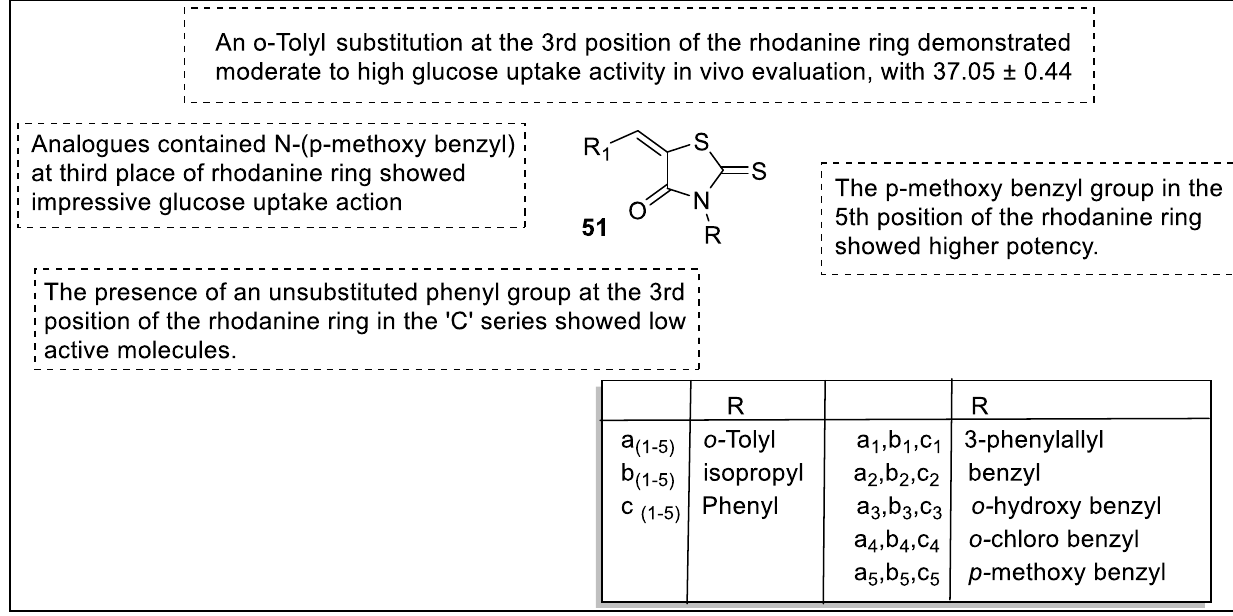
Figure 55. Structural activity relationship of rhodanine hybrids ( 51 ) as potent PPAR